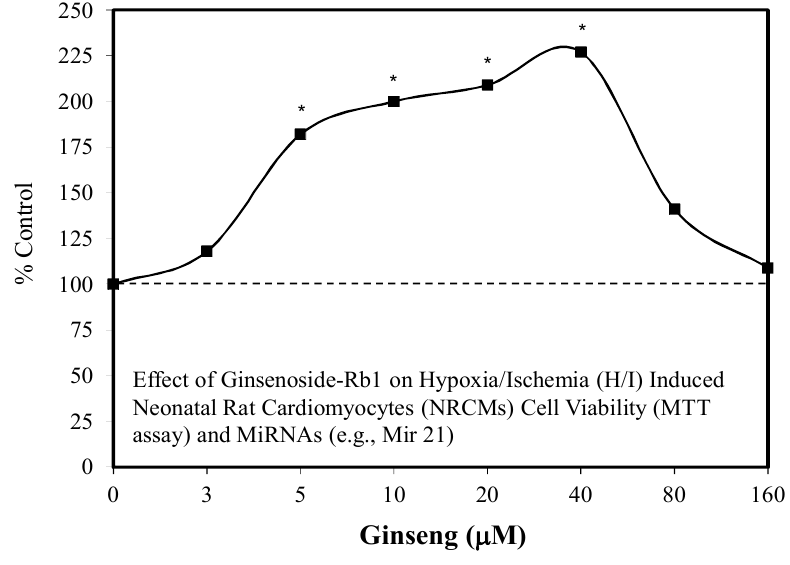
Figure 17. Effect of ginsenoside-Rb1 on hypoxia/ischemia (H/I)-induced neonatal rat cardiomyocytes (NRCMs) cell viability (MTT assay) and MiRNAs (e.g., Mir 21) (Source: [80]). Each * represent statistical significance for a data point.